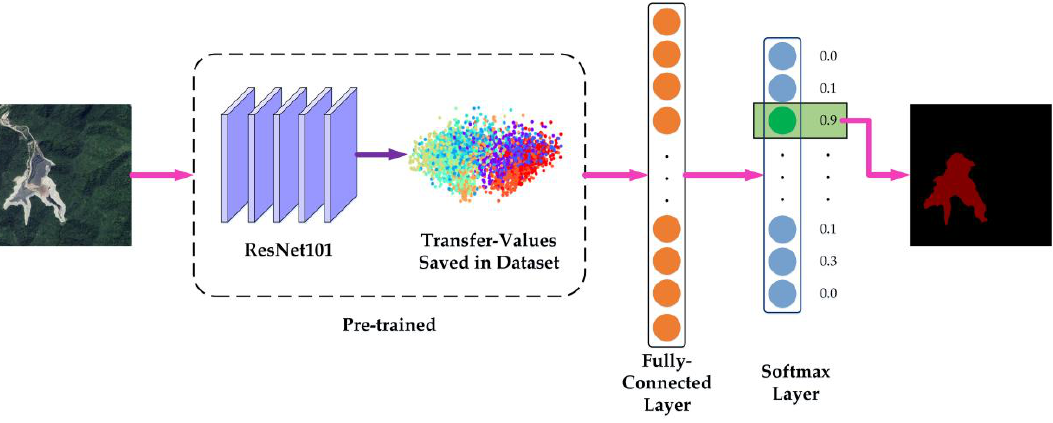
Figure 5. Transfer learning.